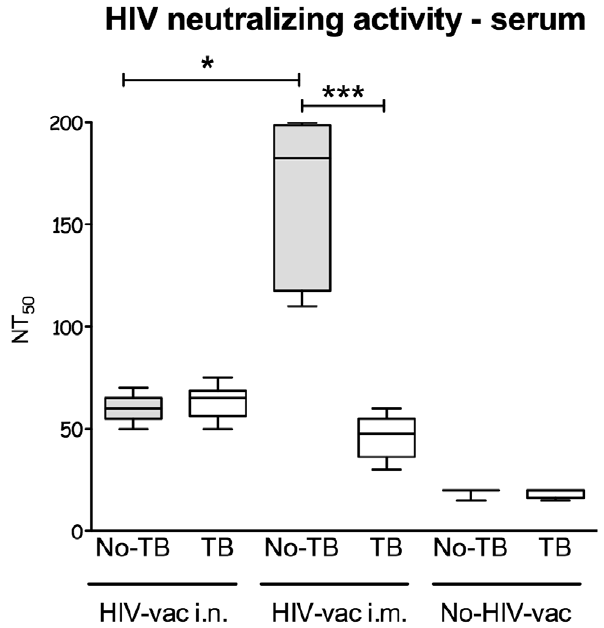
Figure 3. Effect of Mtb infection on MultiHIV DNA/protein- induced HIV neutralizing activity in mouse sera. Sera from uninfected and Mtb -infected C57BL/6 mice subsequently vaccinated i.n. or i.m. with MultHIV DNA/protein were collected 4 wk post-vaccination. Ex vivo HIV-1 neutralization assay was performed on PHA-stimulated PBMCs using two heterologous HIV-1 strains and serially diluted immune mouse sera as described in Materials and Methods. Neutral- ization titer is defined as reciprocal dilution of serum resulting in 50% inhibition of viral infectivity estimated on the basis of HIV p24 antigen production in PBMCs (NT 50 ). Median NT 50 of 6–8 mice/group from one individual experiment is shown as a solid line. The box defines the 75th and 25th percentiles and the whiskers define the maximum and minimum values (*: P , 0.05; ***: P , 0.001). The HIV neutralizing activity in mouse sera was investigated in two separate experiments.